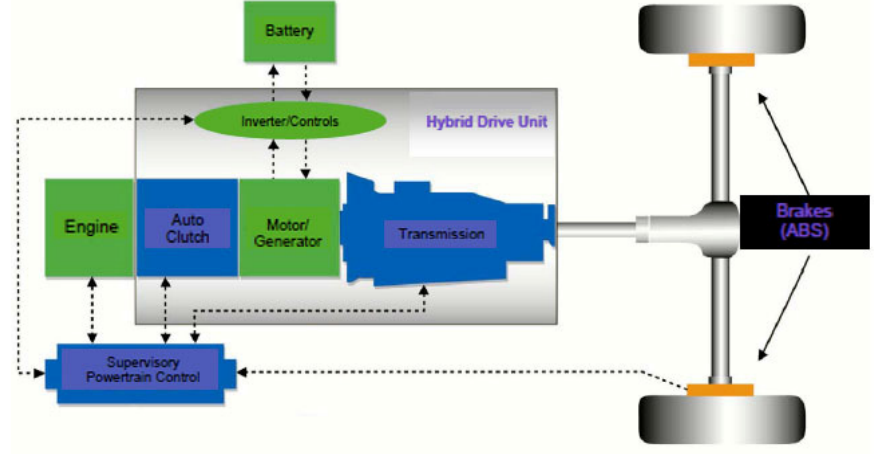
Figure 1. HEV propulsion system. Table 1. The parameters of HEV platform.